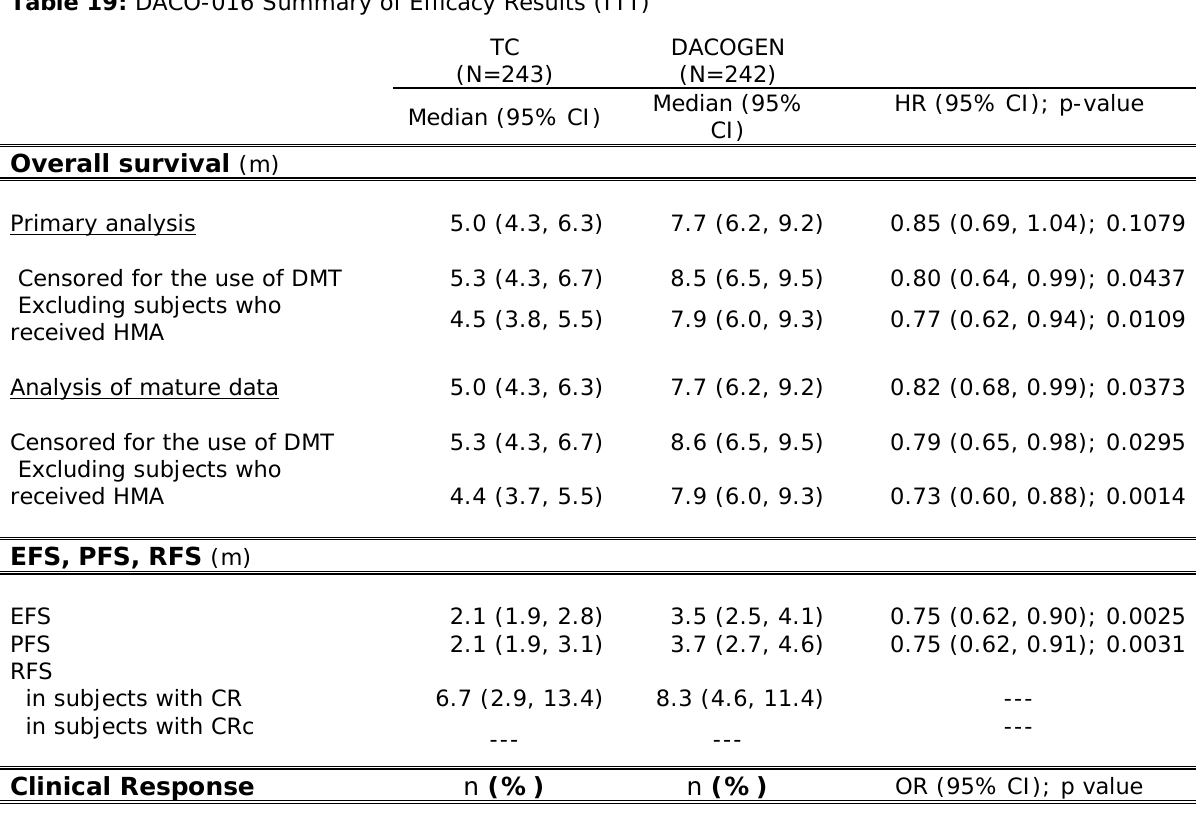
Table 19: DACO-016 Summary of Efficacy Results